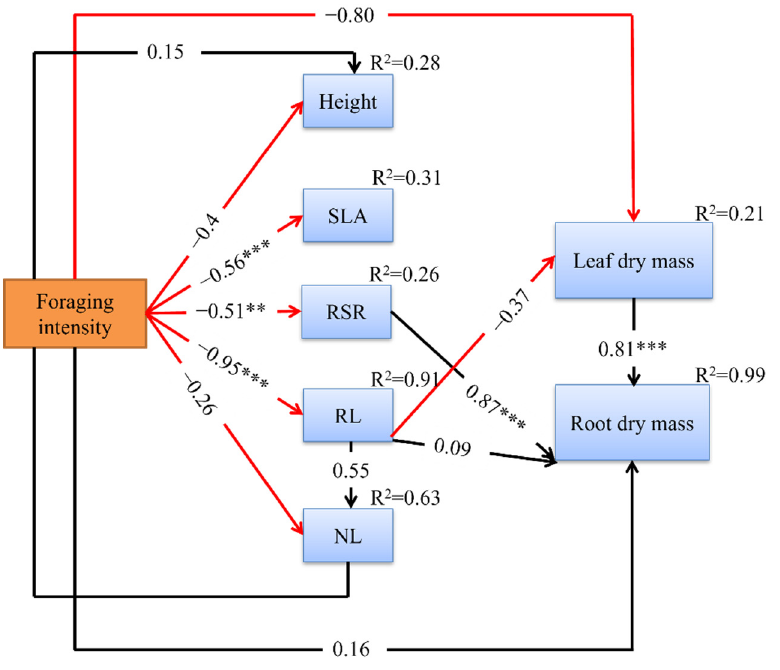
Figure 6. Structural equation modeling (SEM) of foraging intensity as a predictor of leaf dry mass and root dry mass through direct and indirect effects mediated by changes in height, SLA, RSR, RL, and NL. Models show the direct and indirect effects of how bird foraging and plant traits on dry mass of C. thunbergii . (chi-square ( χ 2 ) = 15.245, degree of freedom (df) = 13, p = 0.292, comparative fit index (CFI) = 0.987, root mean square error of approximation (RMSEA) = 0.095). Red and black solid arrows represent negative and positive pathways, respectively. Numbers are the standardized path correlation coefficients (Pearson’s r). R 2 denotes the proportion of variance explained by indicators of the model. Significance at 95% confidence level: ** p < 0.01; *** p < 0.001.